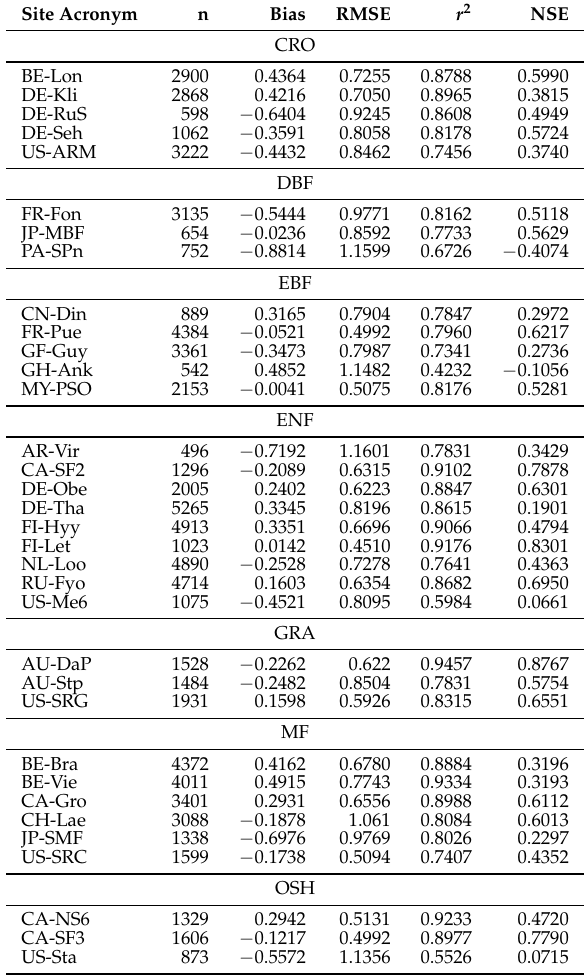
Table 3. Bias (mm/day), root mean squared error (RMSE) (mm/day), coefficient of determination ( r 2 ) and the Nash–Sutcliffe efficiency index obtained from contrasting the simulated daily ET against in situ measurements at flux tower stations as compiled in the FLUXNET 2015